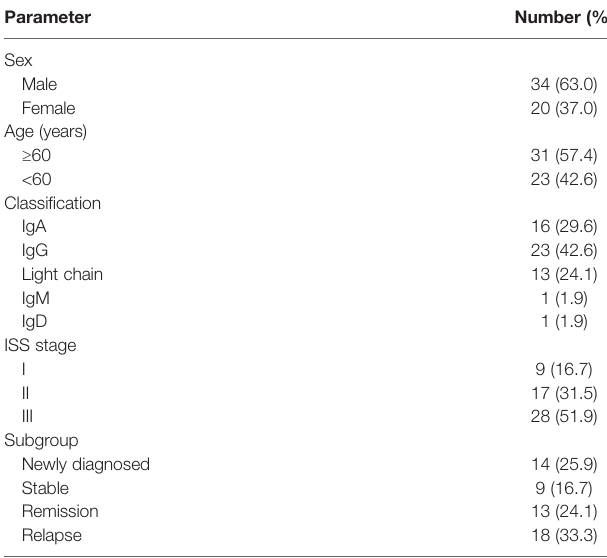
TABLE 1 | Characteristics of the 54